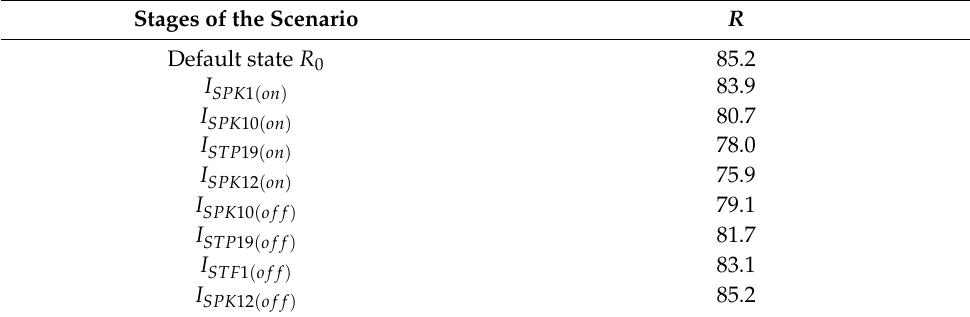
Table 7. Reference Object Resilience